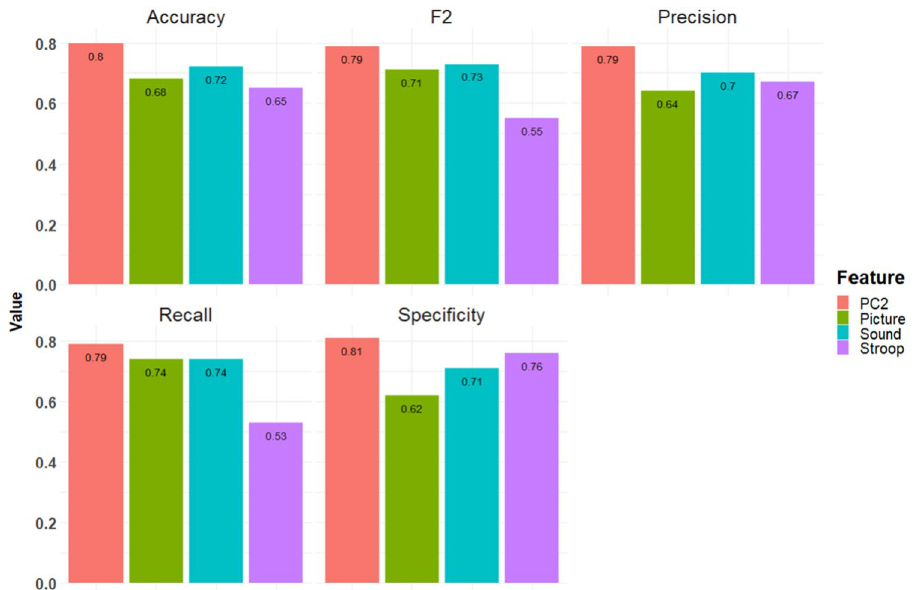
Figure 5. Results of performance metrics of SVM classification. The performance metrics resulted from SVM classification using input features of six PC2 loadings and six ROIbvals of picture, sound, and Stroop, respectively. The results showed that PC2 loadings achieved the highest scores for all performance metrics compared to ROIbvals of picture, Stroop, and sound. LOOCV was used as an evaluation of model